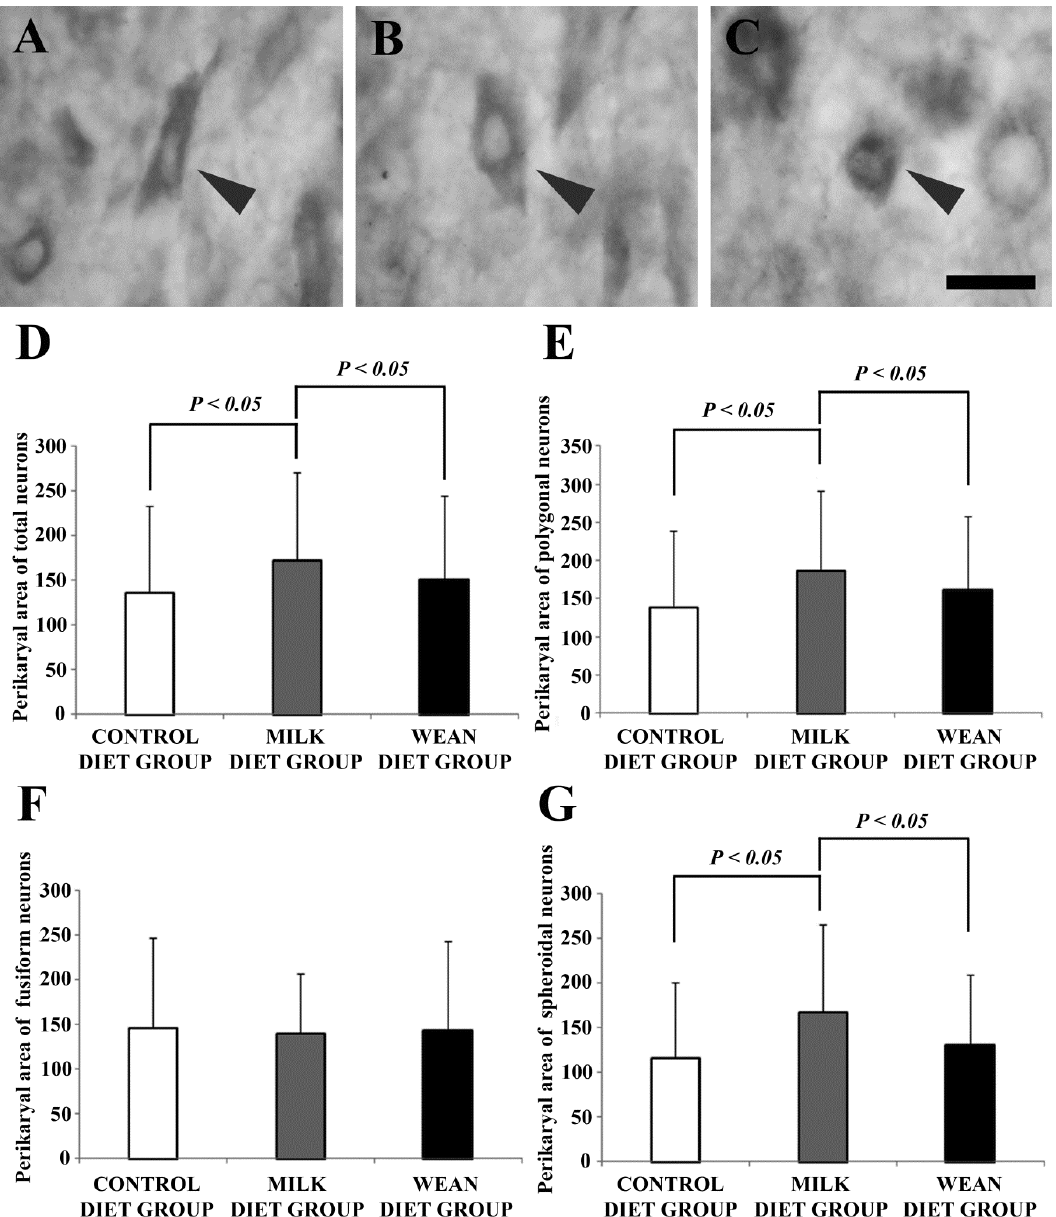
Figure 1. Brightfield photomicrographs of coronal sections ( A – C ) and histograms ( D – G ) showing morphological types and morphometric analysis of oxytocin-immunoreactive neurons in the paraventricular nucleus. Note that neurons show a polygonal ( A ), fusiform ( B ), and spheroidal ( C ) morphology (arrowheads). The mean perikaryal area is significantly larger in the milk diet group than in the control and wean diet groups ( D ). In particular, the milk diet group exhibits the largest areas of polygonal ( E ) and spheroidal ( G ) neurons. Scale bar = 20 µm in C (applies to A – C).